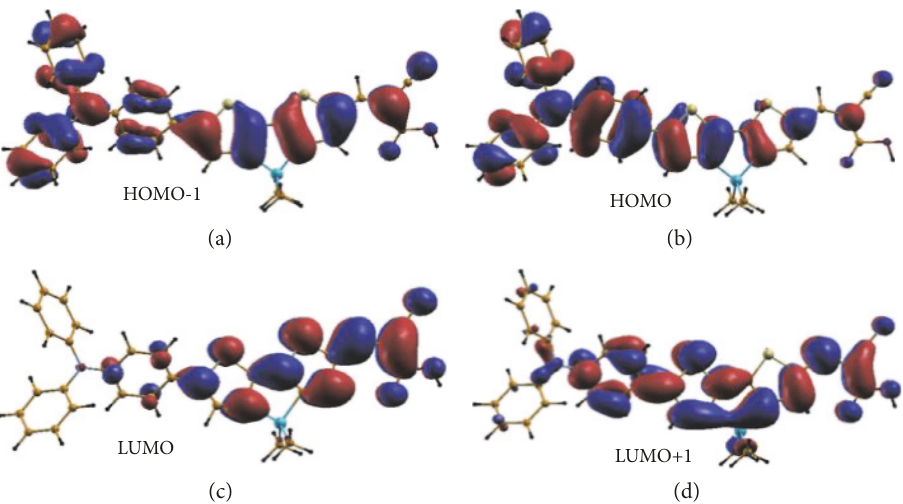
Figure 10: Isosurface plots (isovalue =0.2e e/a.u. 3 ) for the molecular orbitals involved in the photoexcitation of the CL1-dye. The orbitals were calculated within